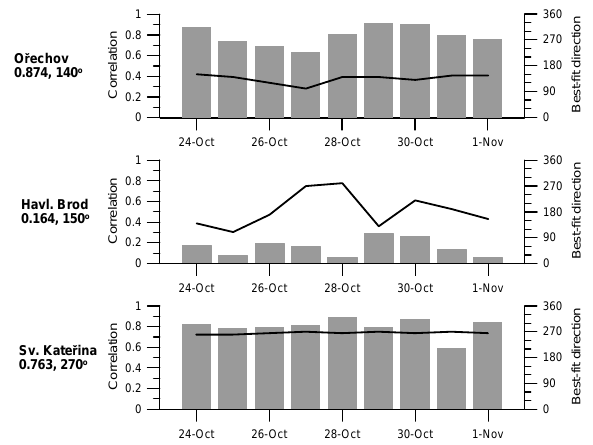
Fig. 5. Best-fit directions (lines) and correlations (bars) between the vector of geoelectric field and the P/S voltage. The figures on the left denote average values over the whole